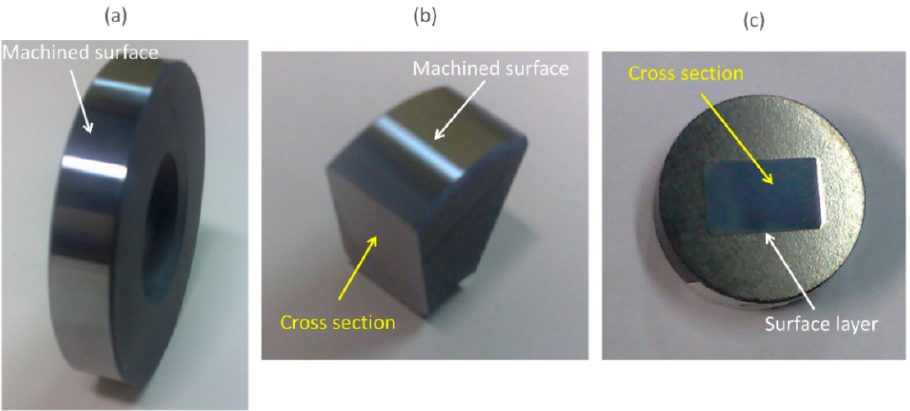
Figure 2. (a) Bearing ring finished by precision hard turning; ( b ) sectioned specimen; ( c ) mounted, polished, and etched specimen. polished, and etched